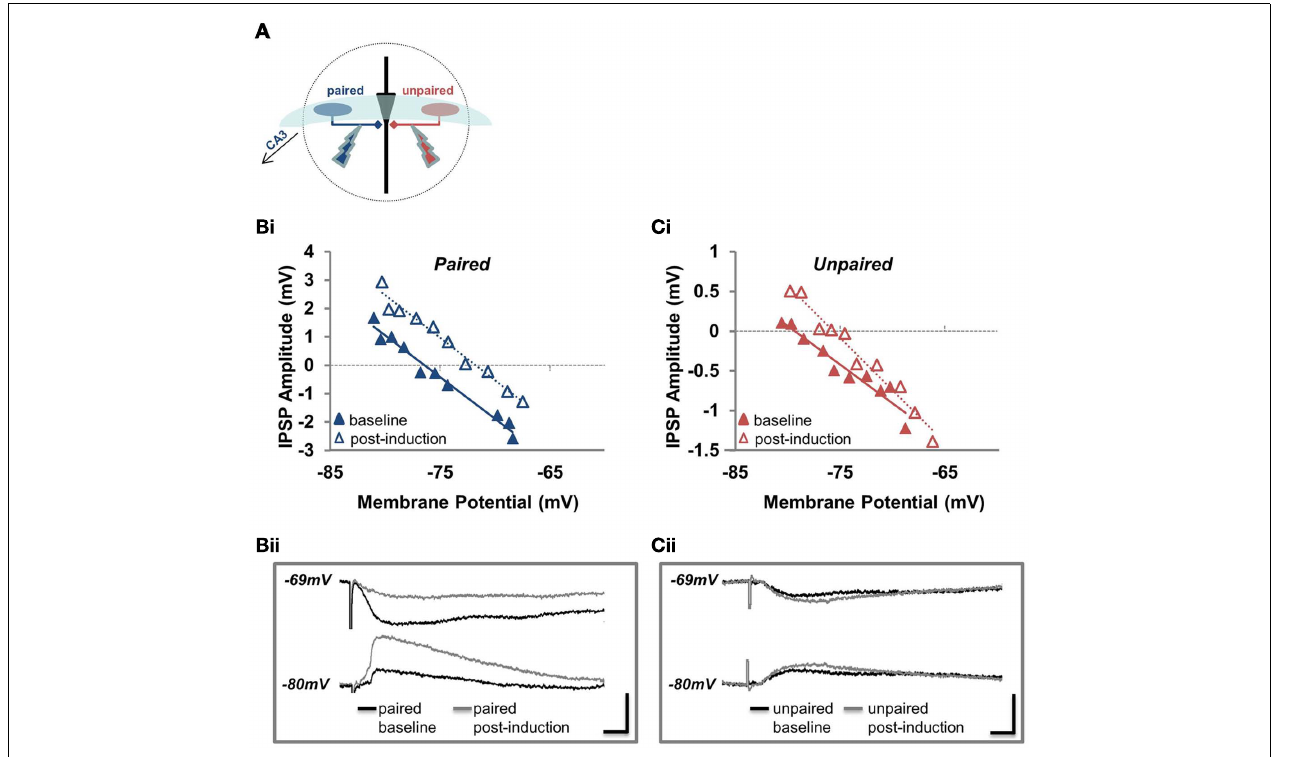
last post-induction time point (gray), for relatively hyperpolarized and depolarized potentials. Scale bars: 2mV, 10ms. (Ci) Example of a recording used to determine E GABA at the unpaired pathway. IPSP amplitude plotted against V m for the unpaired pathway before (baseline; solid red triangles) and after pairing (post-induction; open red triangles). (Cii) Sample traces from the experiment plotted in (Ci) . Current waveforms are overlaid from the baseline period (black) and from the last post-induction time point (gray), for relatively hyperpolarized and depolarized potentials. Scale bars: 2mV,